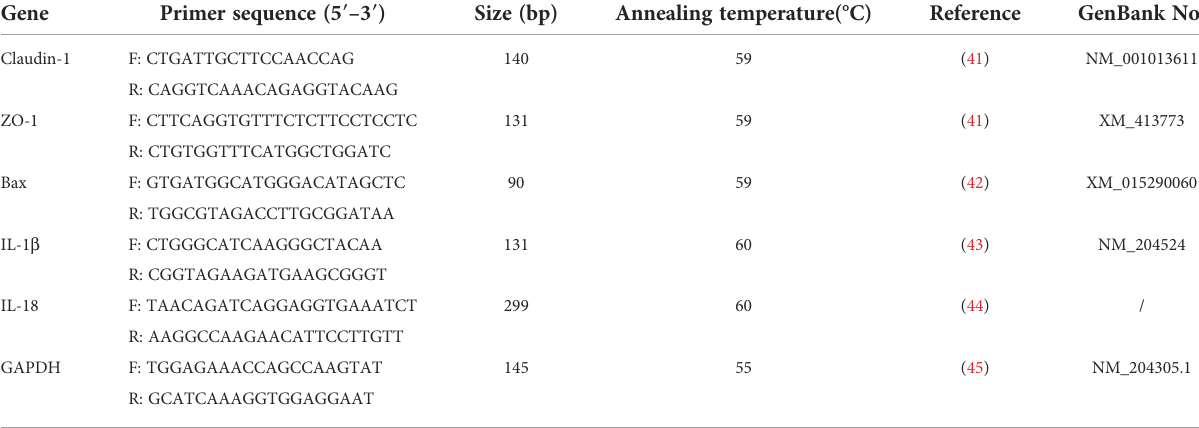
TABLE 2 Primers used to analyze gene expression by quantitative RT-PCR.